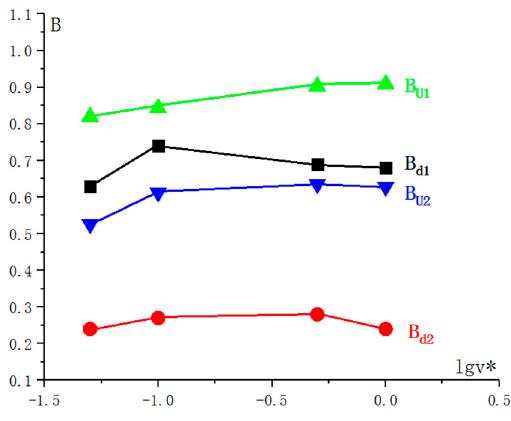
Figure 17. Comparison of the methods.